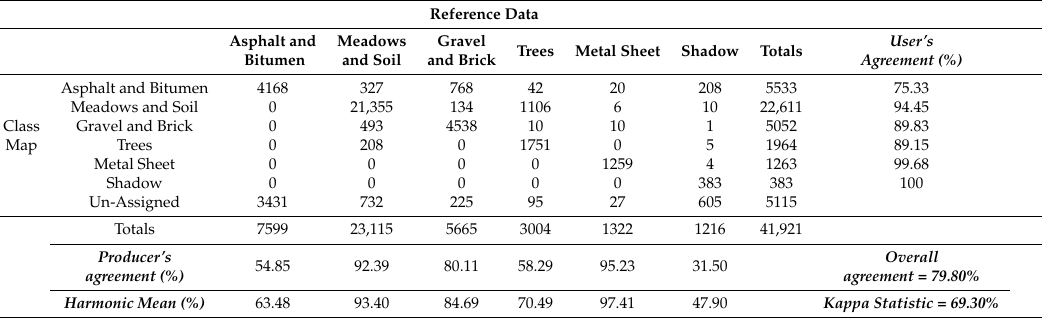
Table 4. Agreement matrix between reference and filtered classification maps for